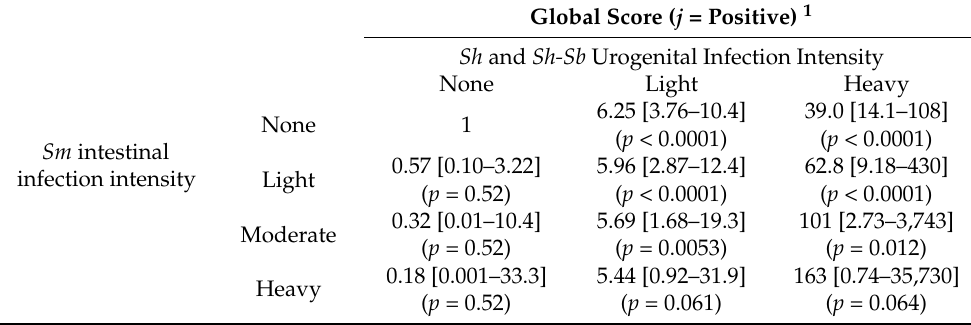
Table 3. Odds ratio (95% confidence interval) and p -values (in parentheses) of urinary tract lesions being in category j or above as assessed by ultrasound among children in Senegal in 2017, depending on schistosomiasis infection intensity and adjusted for age, sex, and study site. Only individuals with complete data on urinary tract lesions, urogenital or intestinal infection intensities, age, sex, and study site were included in the cumulative link logistic regression models ( n = 419; except for bladder intermediate score: n =